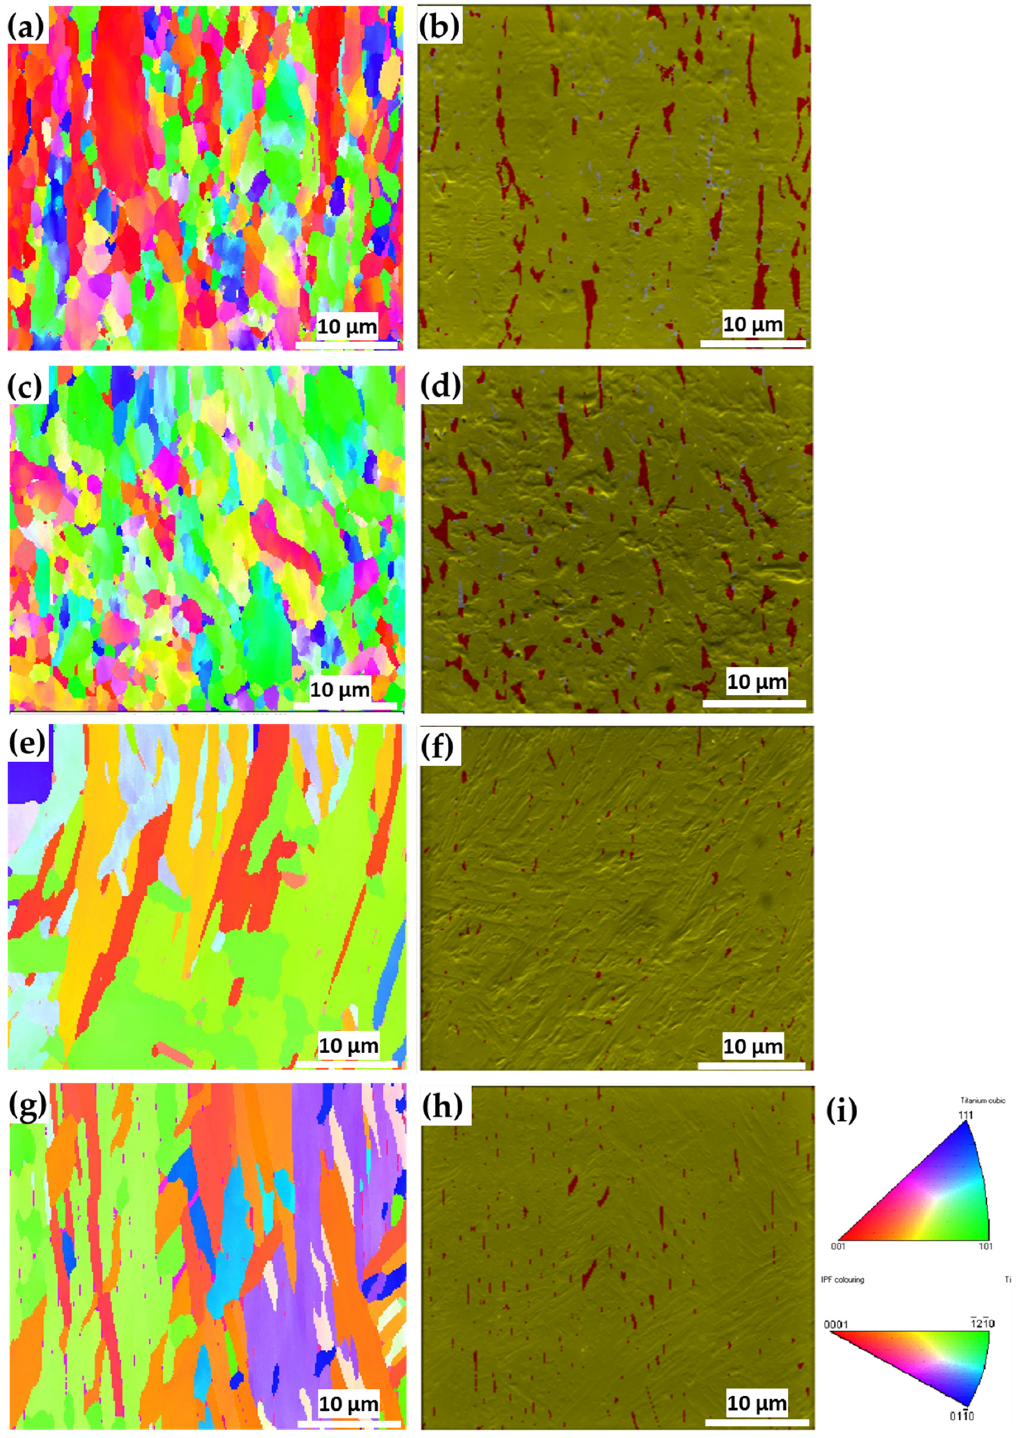
Figure 11. EBSD z -direction IPF maps and SEM SE images with phase identification overlay ( α phase in green-yellow coloring, β phase in red coloring) for ( a,b ) wrought Ti6Al4V sample, facet 1; ( c,d ) wrought Ti6Al4V sample, facet S1; ( e,f ) EBM Ti6Al4V sample, facet 1; ( g,h ) EBM Ti6Al4V sample, facet S1; ( i ) IPF coloring schemes correspond to the β -phase (top) and α -phase (bottom).